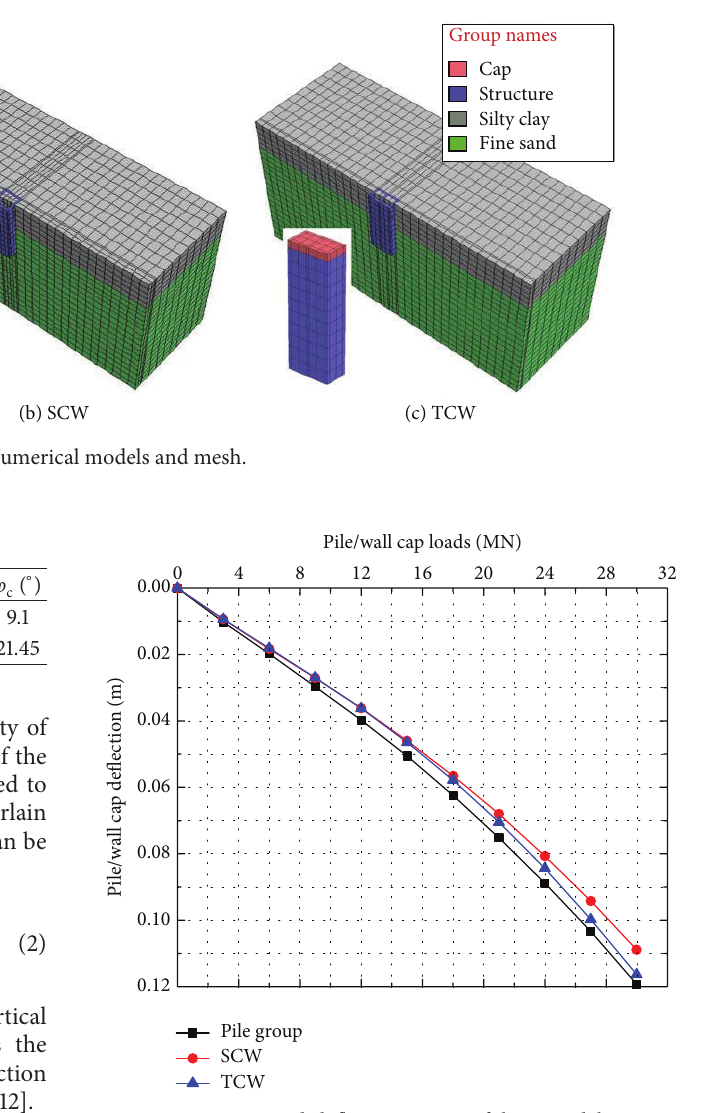
Figure 7: Load-deflection curves of three